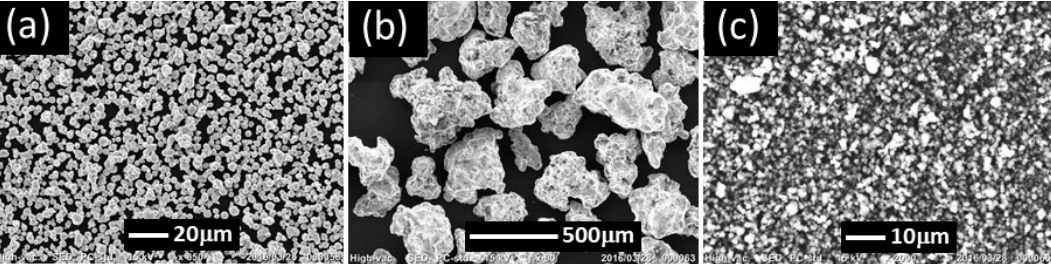
Figure 1. SEM photographs of magnetic and nonmagnetic particles. ( a ) SP, ( b ) LP, and ( c ) NP.